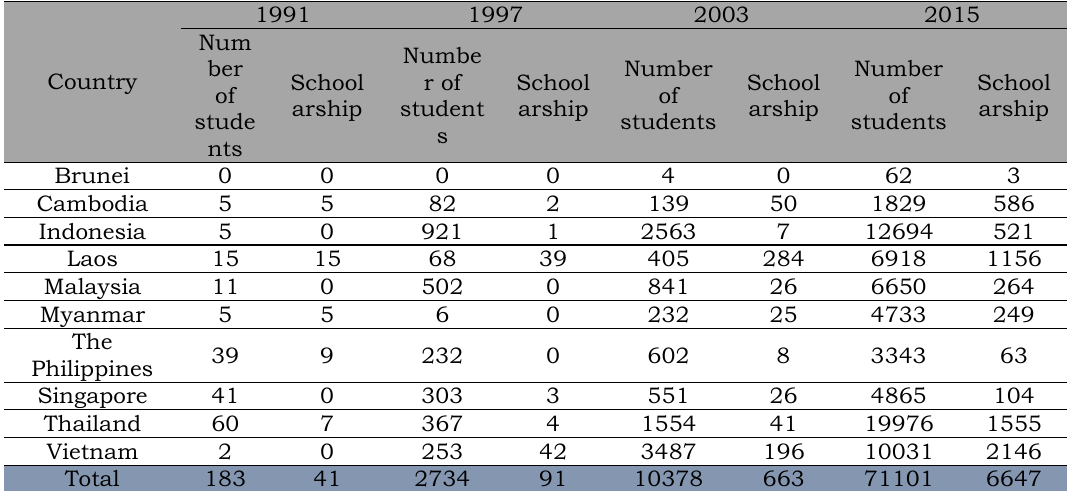
Table 1. ASEAN Students and Scholarship in